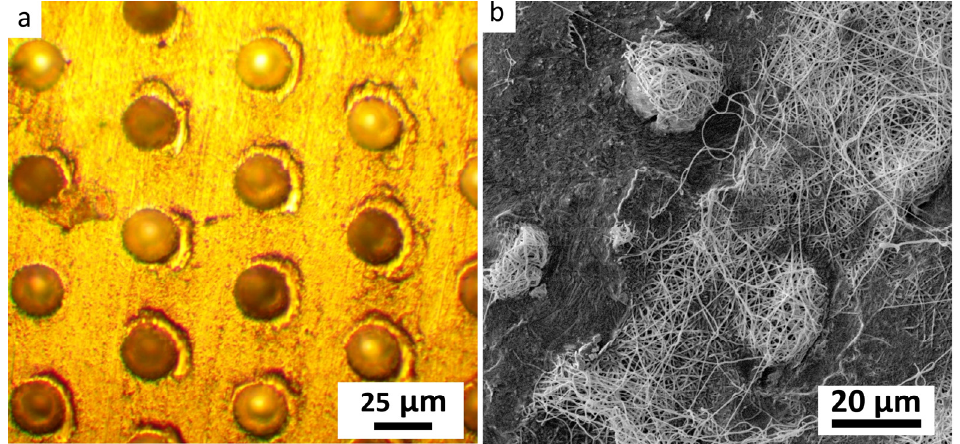
Figure 4. SEM images of ( a ) alumina pattern; ( b ) micro baskets of core-shell PVA–PEG–SiO 2 @PVA–